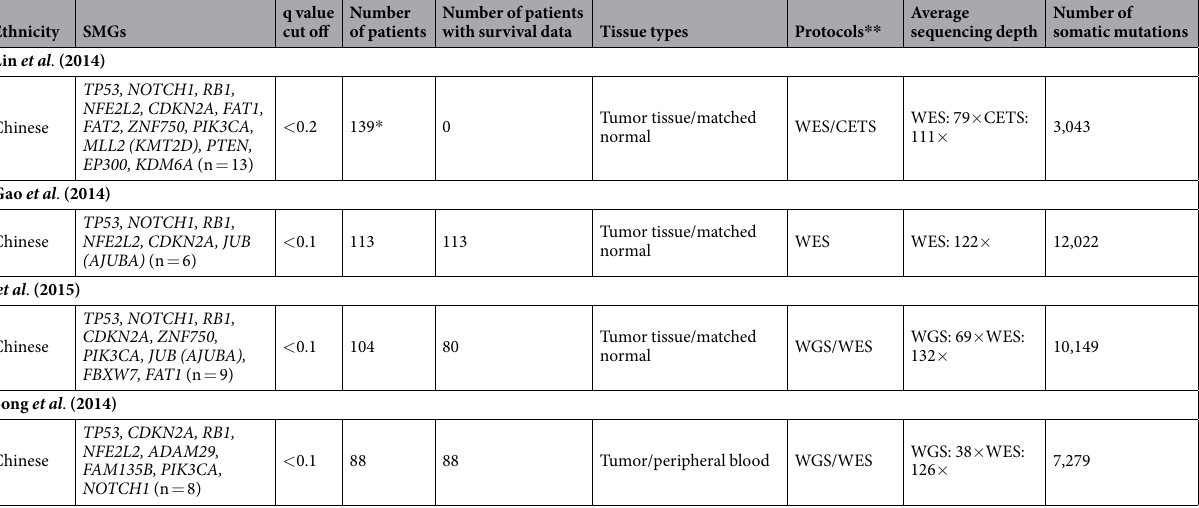
Table 1. Summary of four cancer genome sequencing studies of ESCC in Chinese populations. * Two patients without any gene mutated were excluded in the analysis. ** WES: whole-exome sequencing; WGS: whole- genome sequencing; CETS: coding exons targeted